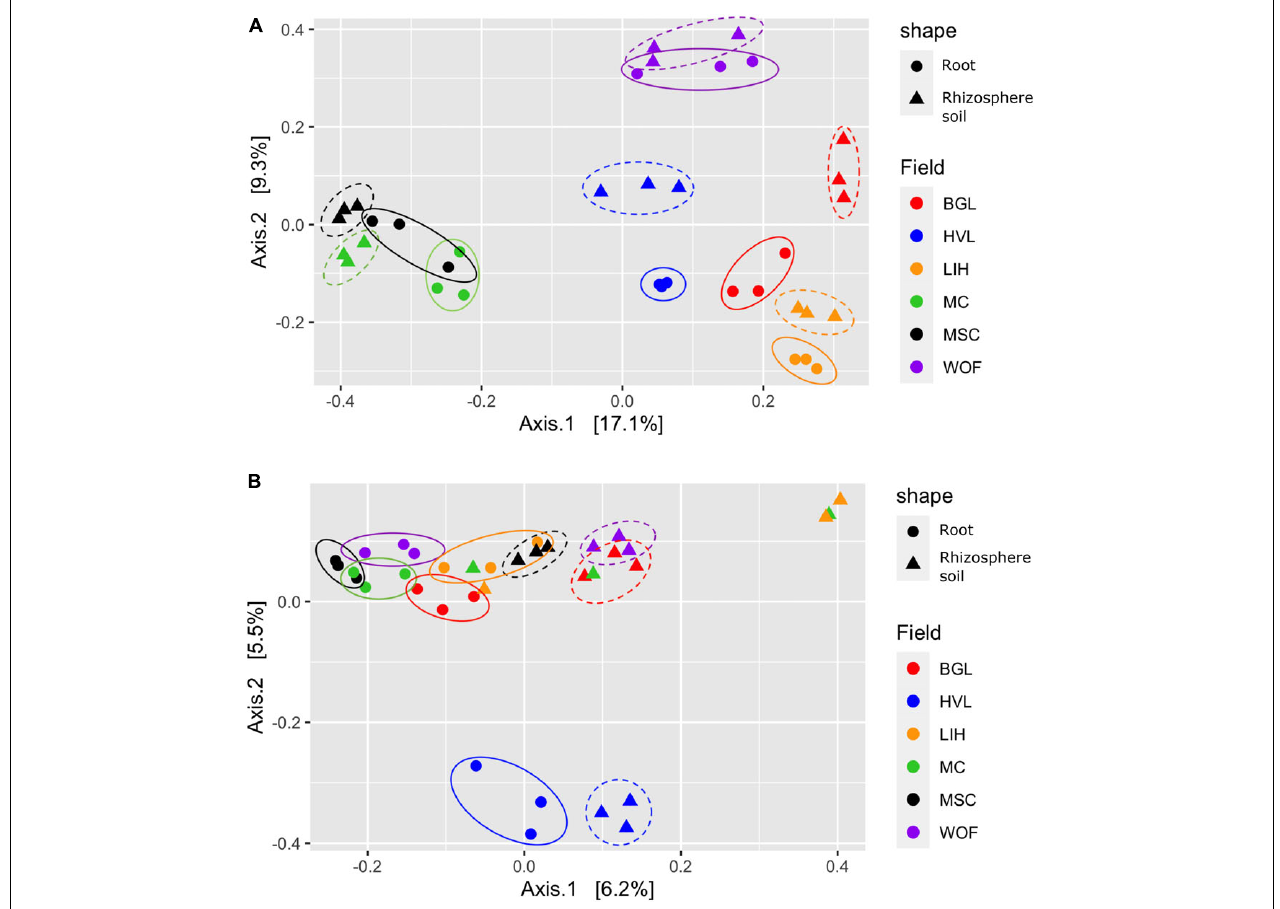
FIGURE 3 | Structure of the community. Principal coordinates analysis (PCoA) showing the community compositions assignments of (A) bacterial 16S rDNA and (B) fungal ITS genes. The variance in the ordinations’ axes 1 and 2 is displayed in parenthesis. Samples from the rhizosphere soil and root are shown by circular and triangle shapes, respectively. Three replicates were used for PCoA analysis. Each color represents filed name: BGL, Bluegrass Lane; HVL, Hudson Valley Lab; LIH, Long Island Horticultural Research and Extension Center; MC, McCarthy CBD Trial; MSC, McCarthy Stress Trial; and WOF, Wegman’s Organic Farm.